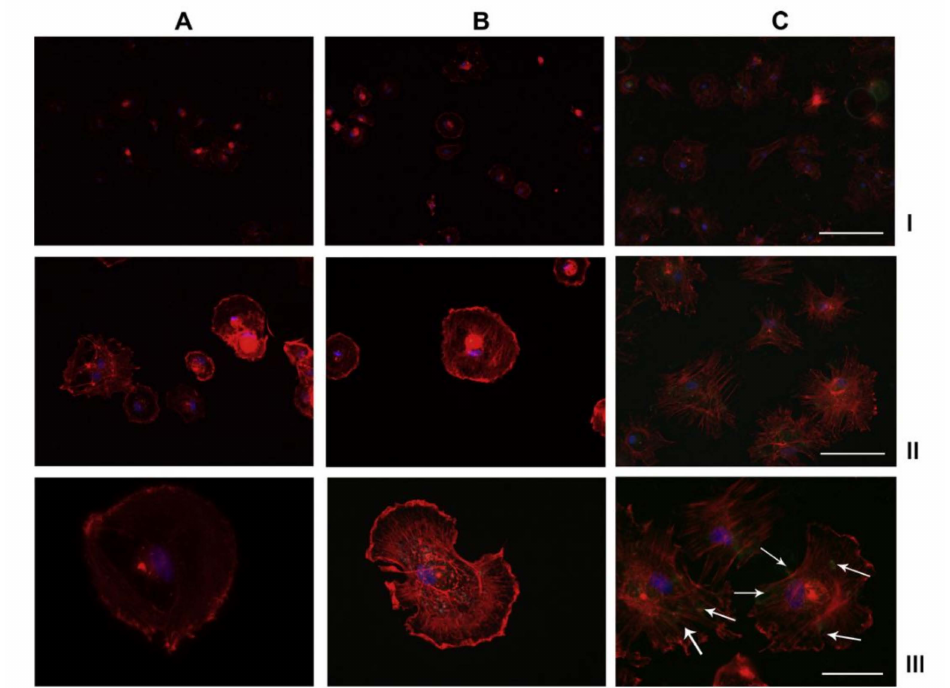
Figure 5. Human osteoprogenitor cell actin filament staining on ( A ) standard cover slips, ( B ) silicon and ( C ) FN-covered silicon after 3 h in cell culture. Red color stains actin and blue stains cell nuclei. On Figure 5c, white arrows indicate the green staining of the dense stress fibers attached to the FN coating. Scale bars are of 200 ( I ), 100 ( II ) and 50 ( III ) µ m, respectively. Reprinted with permission from [51]. Copyright (2011), with permission from